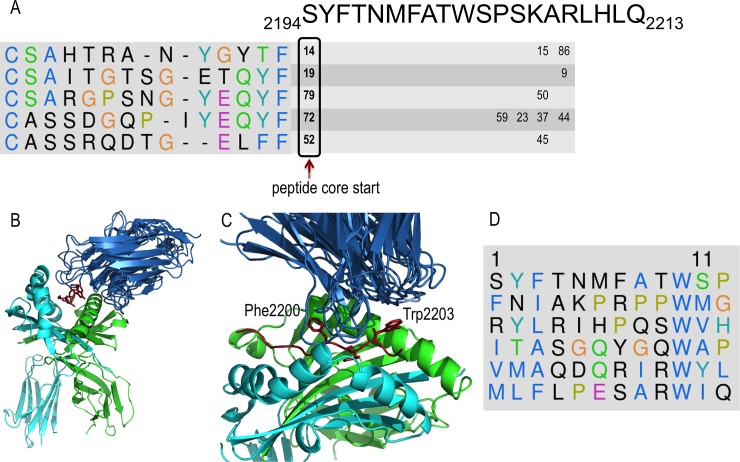
Prediction of FVIII epitopes.A) Consensus based determination of the epitope and its register in the MHCII cavity. CDR3 sequences of the five TCRs and their ranking with respect to different peptide registers in the epitope sequence. Only ranks in the top 100 scores are shown. Peptide FVIII-2194-2205 ranked in the top 100 scoring peptides predicted to bind both HLA-DR1 and each of the 5 indicated TCR-beta variable CDR3 sequences. The predicted consensus core of the epitope for the five TCRs is indicated by an arrow. B) Structural models for the five pMHCII-TCR complexes with the SYFTNMFATWSP 12-mer peptide. The identical MHCII (HLA-DR1) structures within each modeled complex were superimposed, allowing visualization of the different peptide and TCR structural variations. C) The TCR models contact the pMHCII by placing their CDR3 loops in the cavity between FVIII residues Phe2200 and Trp2203. D) The six highest scoring peptides with respect to all five TCRs all have a Trp residue at position 10.